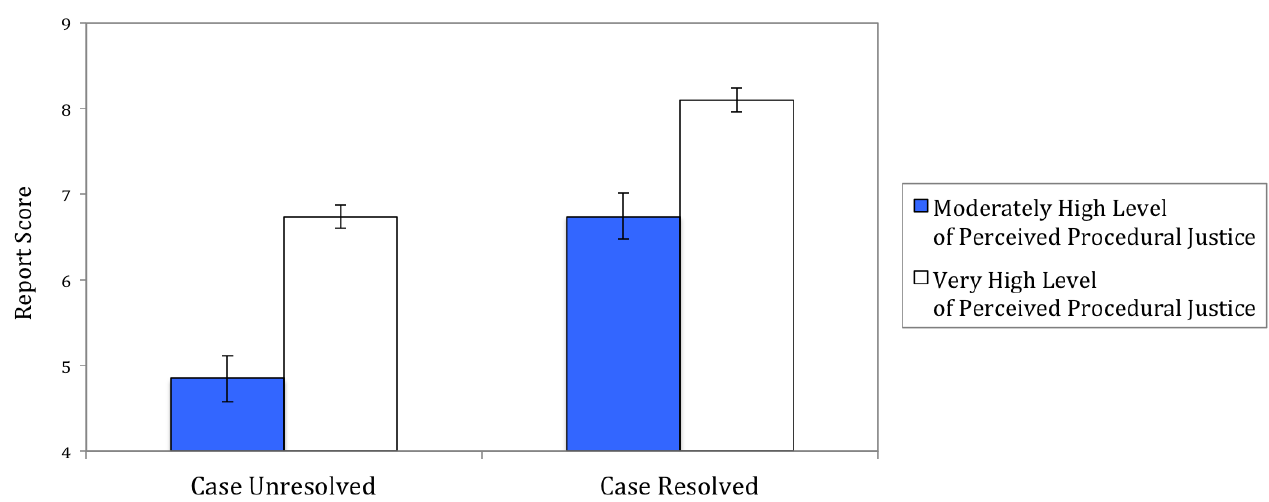
Figure 4 . Report scores awarded by citizens for the handling of their case as a function of their perceptions of procedural justice (moderately high level [-1 SD ] versus very high level [+1 SD ]) and whether the case was unresolved or resolved. Scores are on 10-point scales with higher values indicating higher scores of how the case was handled. Error bars represent standard errors of the